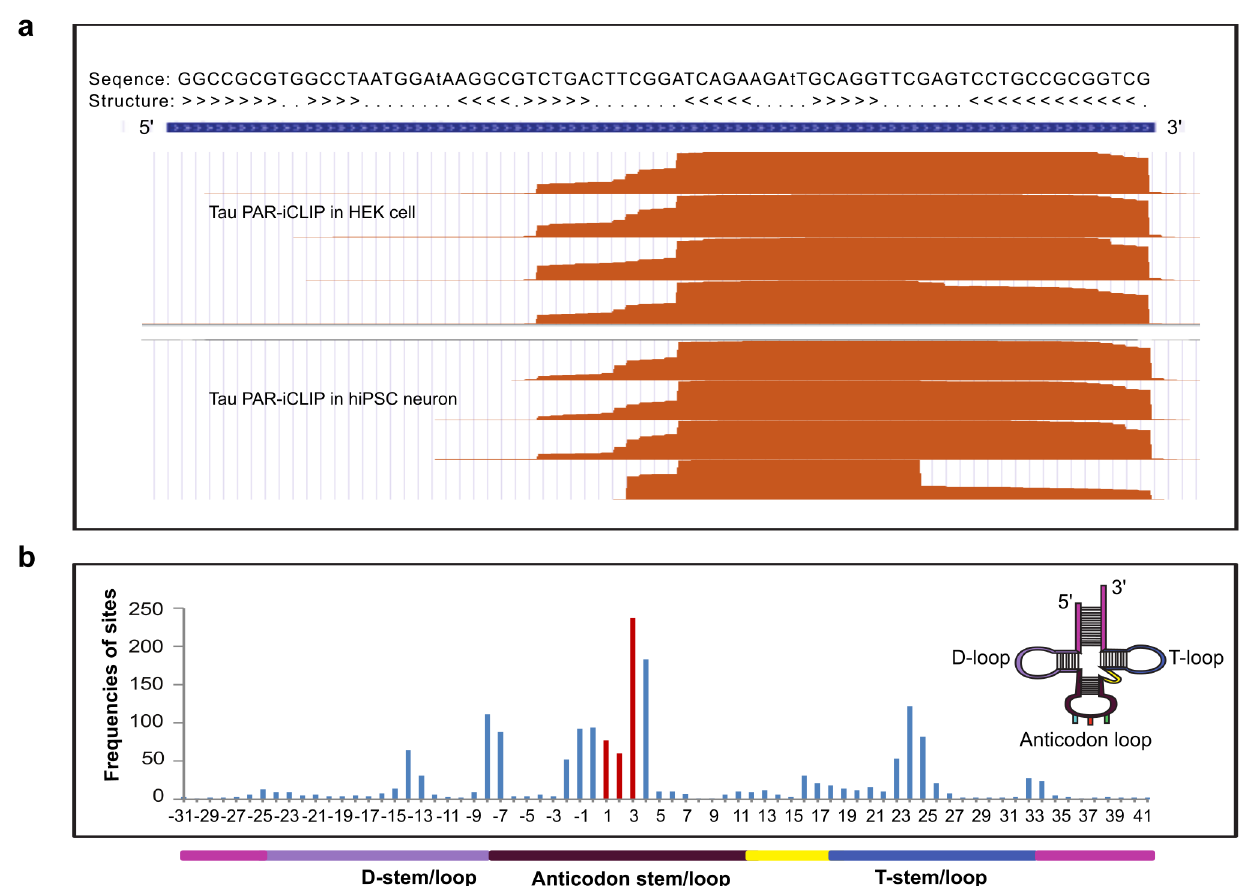
Fig 2. Enrichment of tRNA in PhotoActivatable Ribonucleoside-enhanced Individual-nucleotide resolution UV Cross-Linking ImmunoPrecipitation and high-throughput sequencing (PAR-iCLIP) data. (A) Cross-Linking ImmunoPrecipitation (CLIP) cDNA reads from tau expressedin human-induced pluripotentstem cell (hiPSC)-derivedneurons(neuronCLIP) and from tau expressedin human embryonic kidney (HEK) cells (HEK cell CLIP) that alignedto the chr15.tRNA4-ArgTCG tRNA were found in all CLIP samples, and demonstrated a similar pattern of crosslinking. (B) Analysis of cross-linked sites along tRNA secondarystructure demonstrates the anticodon preference, in which the anticodon(coloredred) regionis designated as position 1–3 for alignment purpose. The colored illustrationof tRNA secondary structure is displayedas an inset, and belowthe x axis in one dimension. The numericaldata used in (B) are includedin S1 Data.